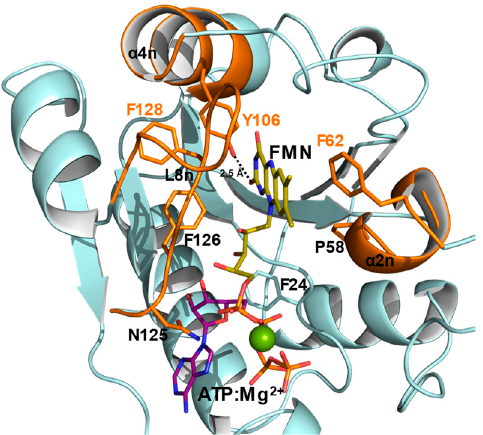
Figure 8. The FMNAT site of Ca FADS. Detail of the catalytic site for the FMNAT activity with FMN (yellow) and ATP:Mg 2 + (magenta) substrates docked according to Reference [12]. P58, F62, Y106, and F128 (sticks), involved in FMN stabilization, and the structural elements in which they are located (cartoon) are highlighted in orange. F24, F126, and the catalytic N215 (located at loop L8n), which are involved in ATP stabilization, are also shown as